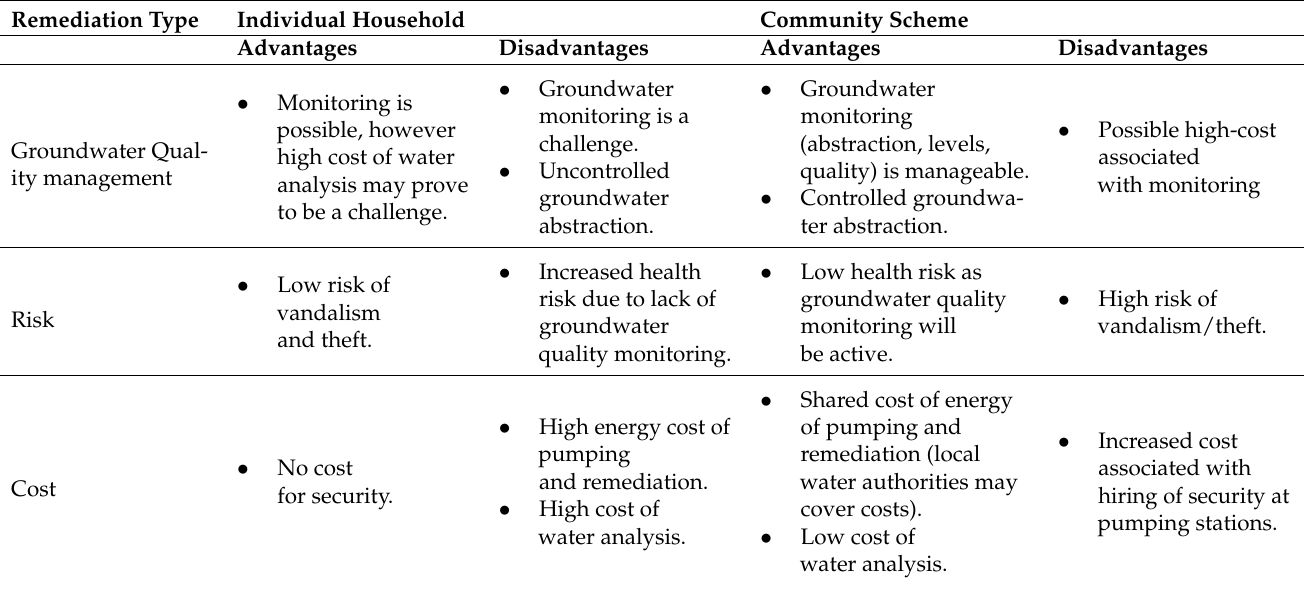
Table 2. Advantages and disadvantages of individual household and community schemes remedia- tion techniques (Pump and